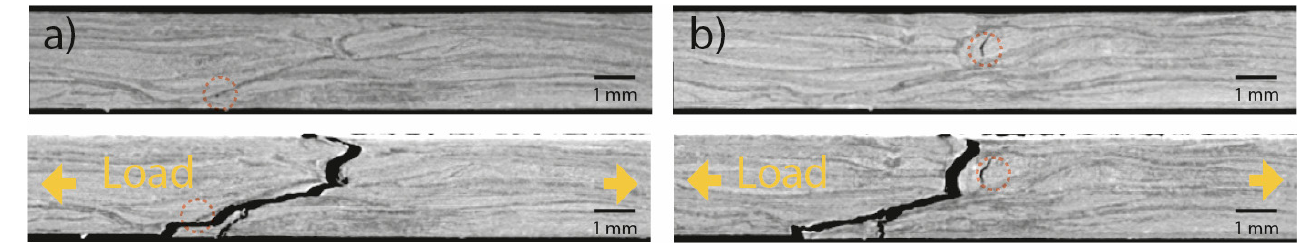
Figure 13. CT Micrograph slices of a Butt tensile specimen before and after failure. ( a ) A small circular void is highlighted in the resin rich area between the tows at the WLD. Even though that the crack proceeds through the resin rich area, it misses the void. ( b ) Another section of the same specimen, before and after testing. A larger void in the fibre tow is encircled, which remained isolated after failure, indicating that a matrix dominated failure occurred.